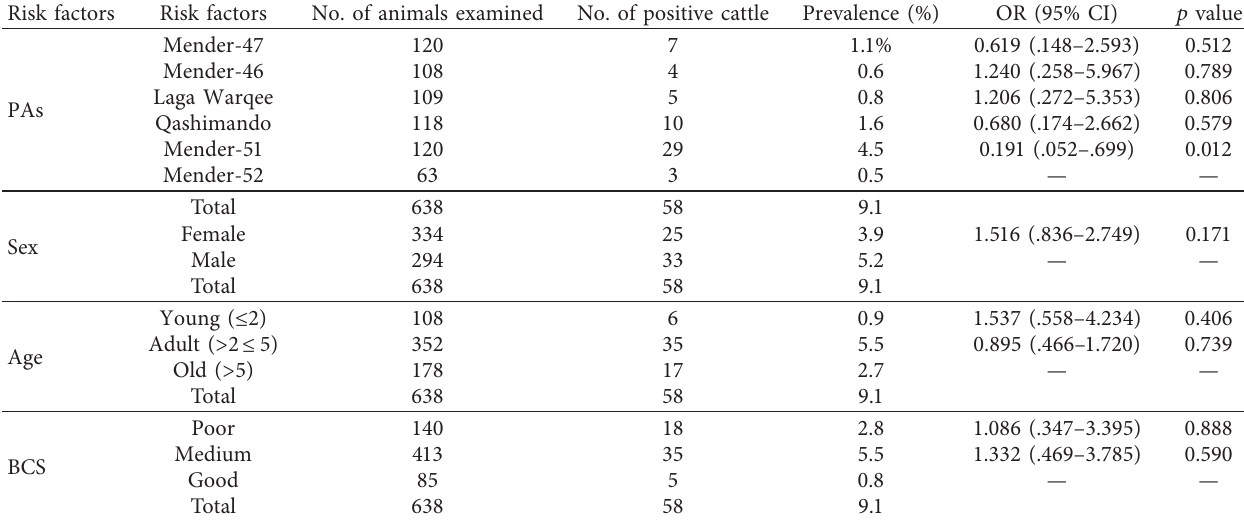
Table 4: Univariable logistic regression analysis of risk factors with the buffy coat result.